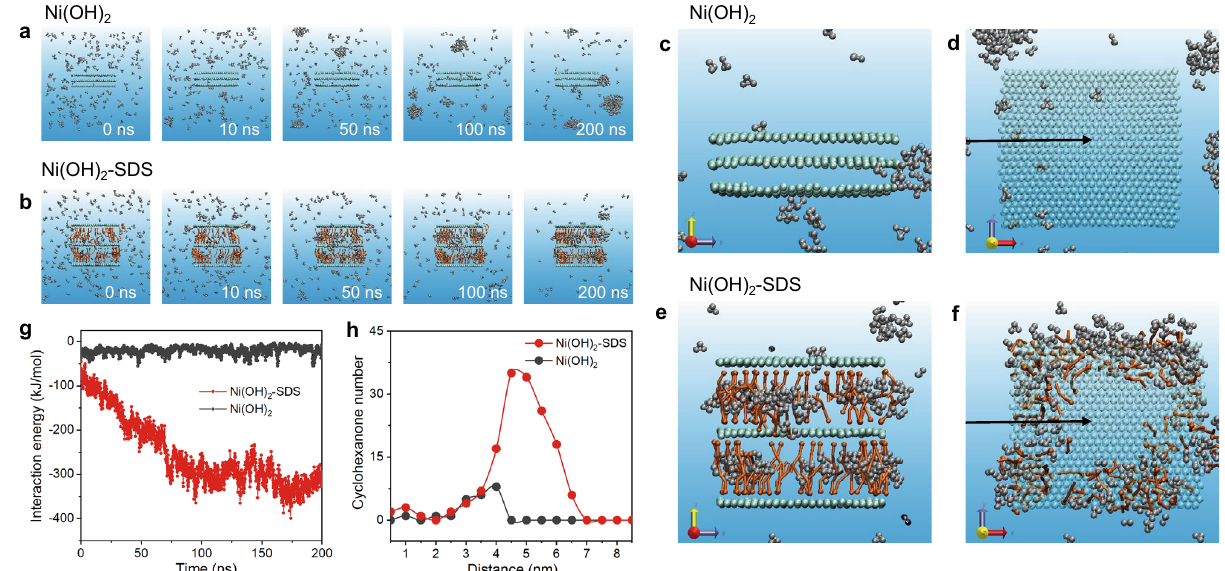
Fig. 5 | Coarse-grained molecular dynamic simulations of cyclohexanone dif- fusion behaviors. The time sequence of typical snapshots of cyclohexanone diffusion dynamics on a pure Ni(OH) 2 and b Ni(OH) 2 -SDS. c Side and d top views of snapshot at 200ns in pure Ni(OH) 2 . e Side and f top views of snapshot at 200ns in Ni(OH) 2 -SDS. g Energy evolution of interaction between